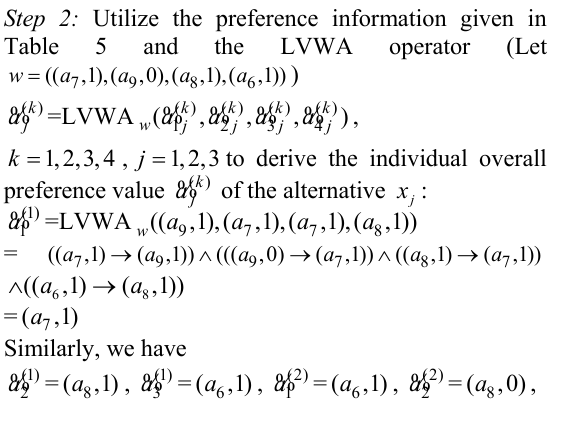
Table 1. Preference information given by decision maker